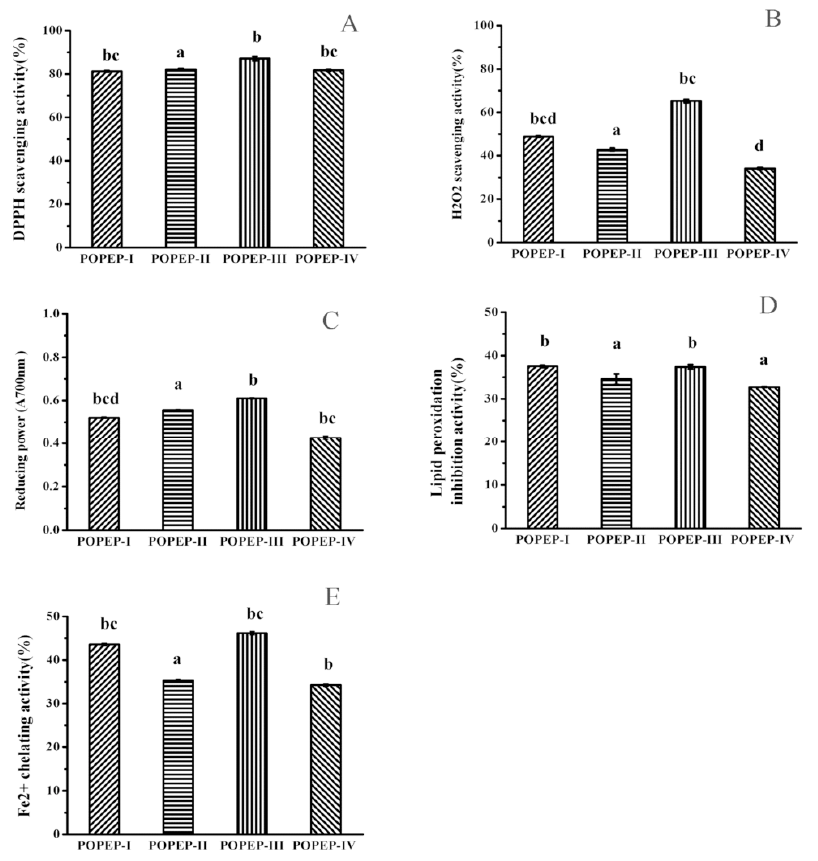
Figure 2. Comparison of in vitro antioxidant effects of different POPEP fractions: ( A ) DPPH scavenging activity. ( B ) Hydrogen peroxide scavenging activity ( C ) Reducing power. ( D ) Inhibitory effect on lipid peroxidation. ( E ) Fe 2+ chelating activity. The values are presented as the mean values ± SD (n = 3), and the same letters above the bars indicate statistically insignificant differences between the groups (p < 0.05). Table 4. Comparison of in vitro antioxidant effects of different POPEP fractions. The values are presented as the mean ± SD (n = 3). The same letters after the mean indicate statistically insignificant differences between the groups (p < 0.05).